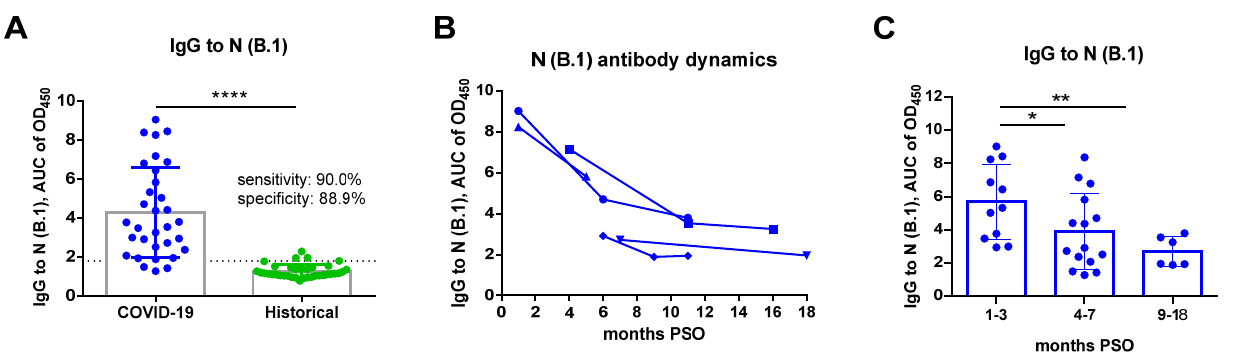
Figure 3. N-based ELISA of serum samples of COVID-19 convalescents and historical samples. ( A ) The area under the OD 450 curve (AUC) values were compared between COVID-19 patients and historical samples to assess the specificity and sensitivity of the developed in-house N-based ELISA. Data were compared by the two-sided Mann-Whitney U test. ( B ) The dynamics of N-specific antibody were analyzed for the selected patients. ( C ) The AUC values of COVID-19 patients grouped by the time post symptoms onset (PSO). Data were compared by one-way ANOVA with Tukey’s multiple comparisons test. The dataset included sera from patients who recovered from COVID-19 ( n = 32, blue symbols) and historical serum samples ( n = 36, green symbols). * p < 0.05; ** p < 0.01; **** p < 0.0001.